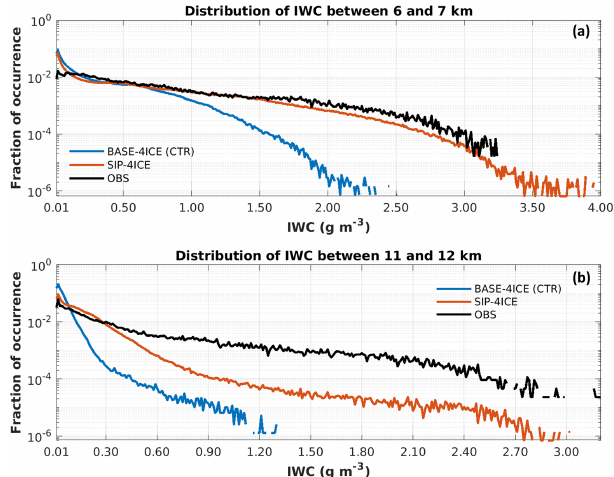
Figure 9. Distributions of ice water content (IWC) from the model simulations and observational data from the HAIC-HIWC aircraft campaign near French Guiana in May 2015. The bin width of 0.01gm − 3 is used. Panel (a) displays results from between alti- tudes of 6 and 7km and with observational data from the NRC Con- vair 580 aircraft, and panel (b) presents results between altitudes of 11 and 12km and with the observational data from the SAFIRE Falcon 20